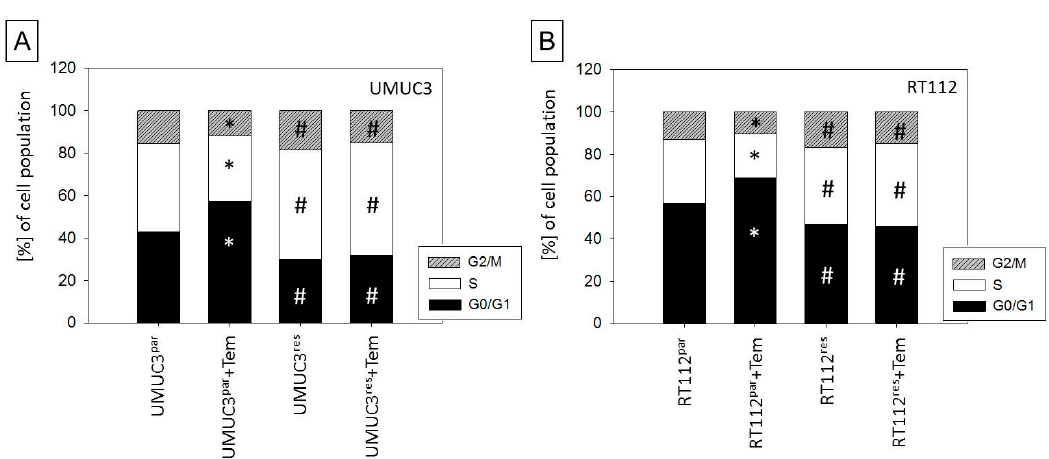
Figure 2. Cell cycle distribution following temsirolimus [10 nmol/mL] exposure. Percentage of parental and resistant ( A ) UMUC3 and ( B ) RT112 in G0/1, S, and G2/M phase is indicated. Controls remained untreated. One representative of three separate experiments is shown. * indicates significant difference to the controls. # indicates significant difference between res and par controls.